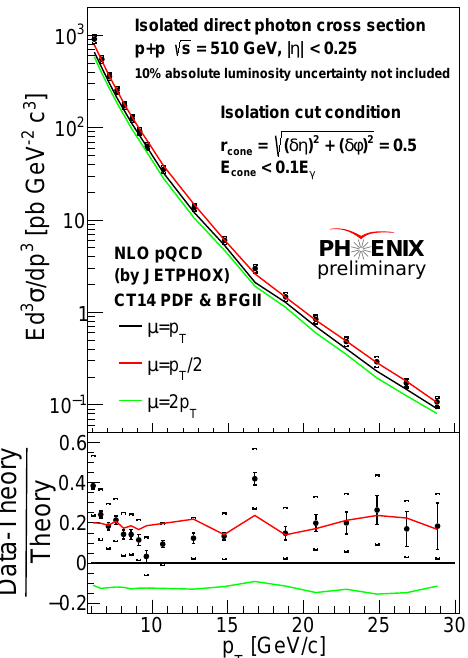
Figure 1: Isolated direct photon cross section as a function of p compared with JET- T PHOX NLO pQCD calculations [ 24 ] for different renormalization and factorization / 2 (dashed line), p scales µ = p (solid line), 2 p (dotted line). The bars represent T T T statistical uncertainties and square brackets are for systematic uncertainties. The bottom plot shows the comparison of data and calculations.